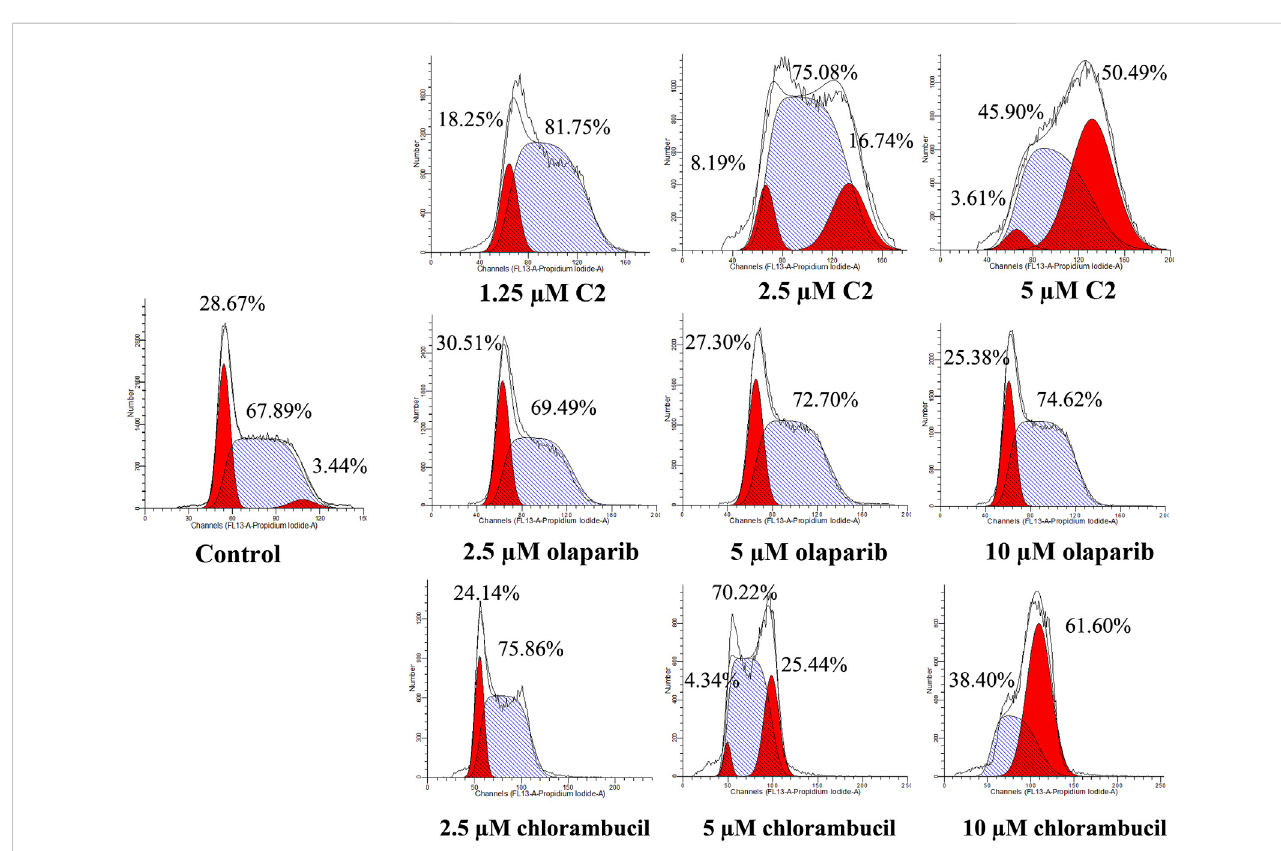
FIGURE 4 Cell cycle analysis of K562 cells treated with molecule C2 , olaparib, or chlorambucil. Cells were treated with molecule C2 (1.25, 2.5, or 5.0 µM), olaparib, or chlorambucil (2.5, 5.0, or 10 µM) at different concentrations for 24 h. The results were evaluated using fl ow cytometry.